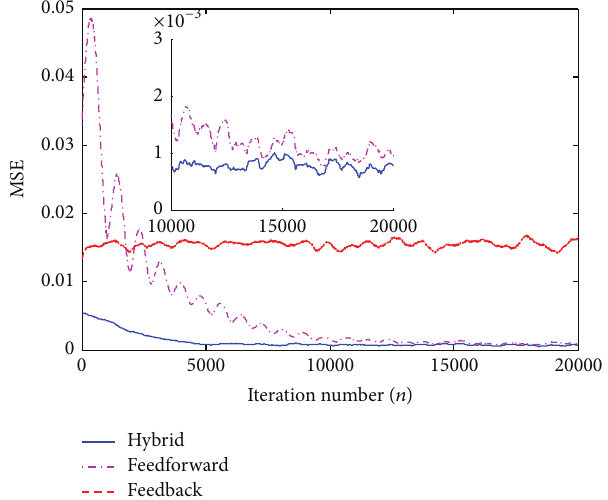
Figure11:TheMSEusingthefeedforwardcontrol,feedbackcontrol, and hybrid control.